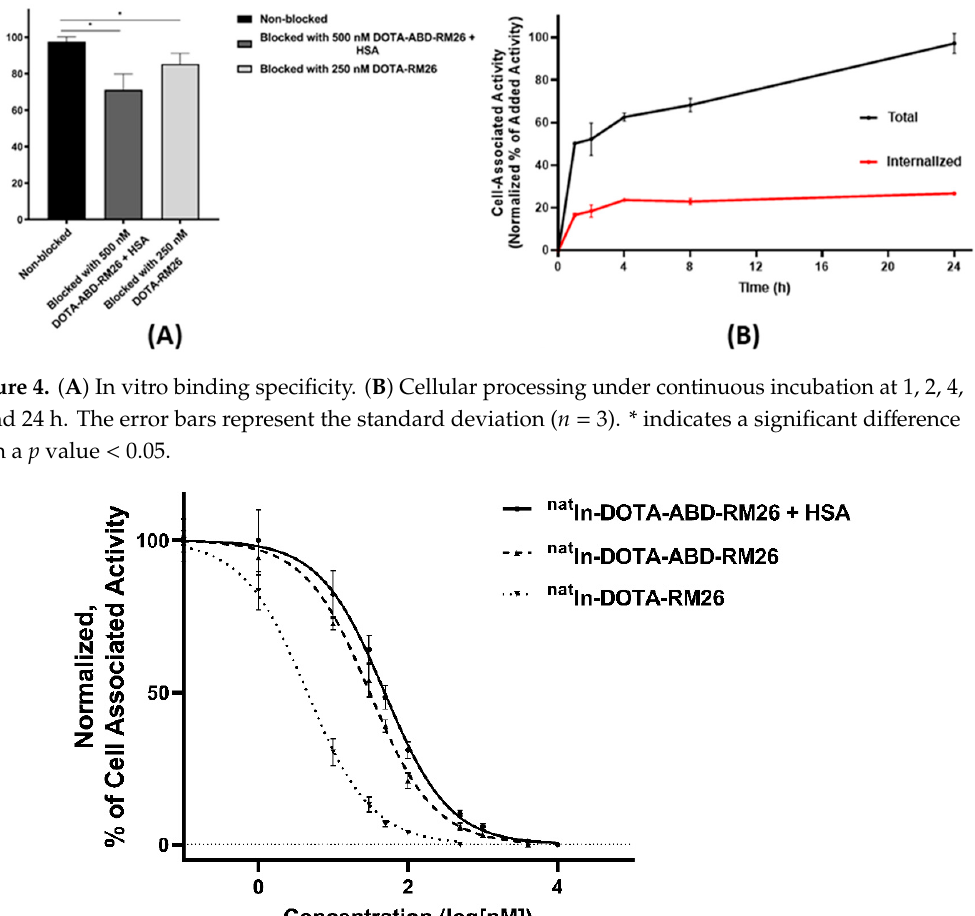
Figure 4. ( A ) In vitro binding specificity. ( B ) Cellular processing under continuous incubation at 1, 2, 4, 8 and 24 h. The error bars represent the standard deviation ( n = 3). * indicates a significant difference with a P value < 0.05.